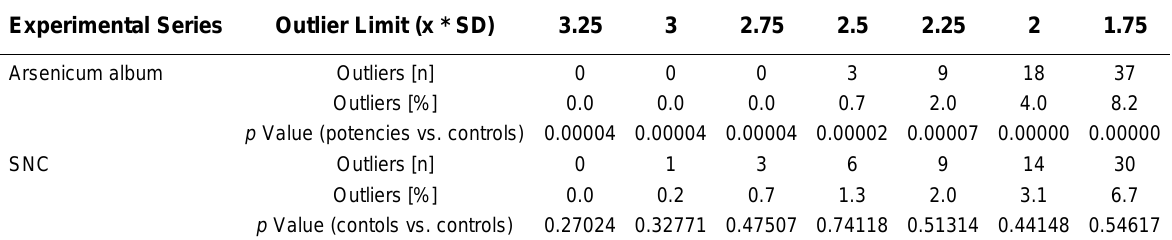
ANOVA F -Test Statistics for the Main Treatment Effect of the Outcome Parameter Growth Rate r Days 2 – 6 as a Function of Excluded Extreme Values (Limits 3.25  SD – 1.75  SD) (area) Experimental Series